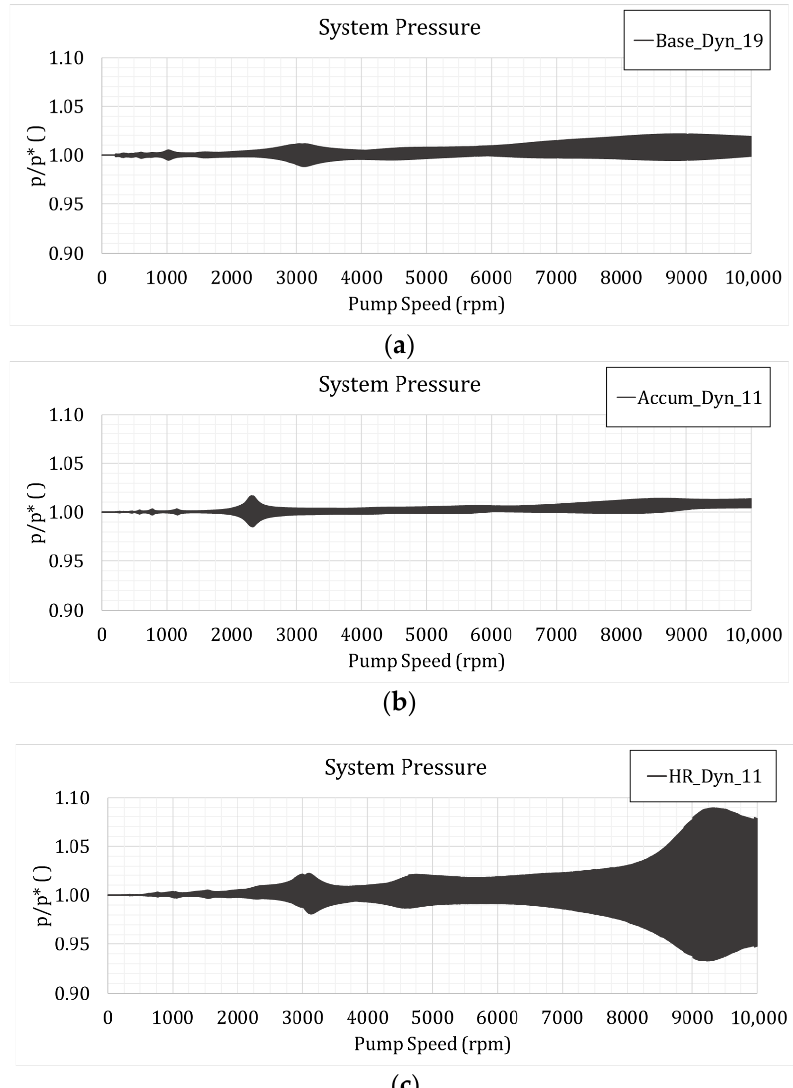
Figure 11. System pressure of: ( a ) Base_Dyn_19; ( b ) Accum_Dyn_11; ( c ) HR_Dyn_11.